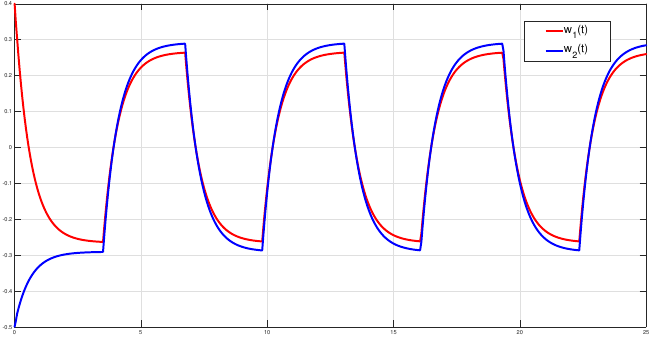
Figure 8. The time responses of the states w 1 ( t ) and w 2 ( t ) of system (71) for the external inputs x ( t ) = [ 1 + cos ( 2 t ) ,1 − sin ( 2 t )] T in Example